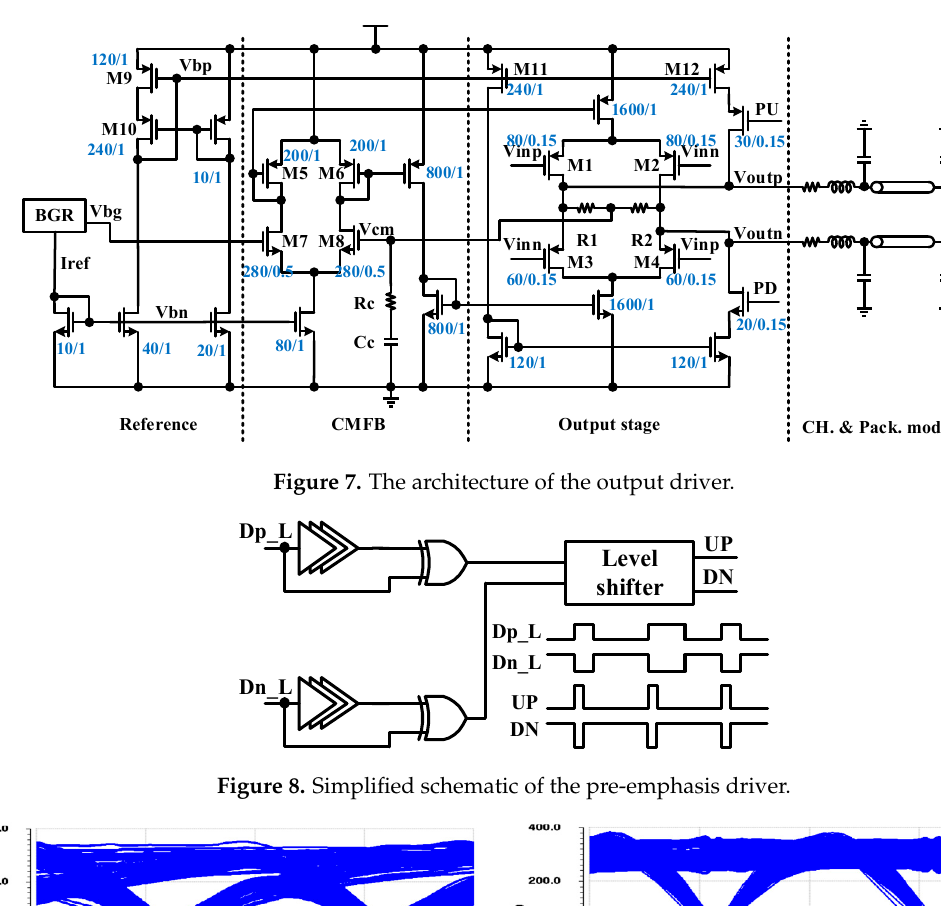
Figure 9. Simulated result of the eye diagram ( a ) without and ( b ) with the pre-emphasis driver.